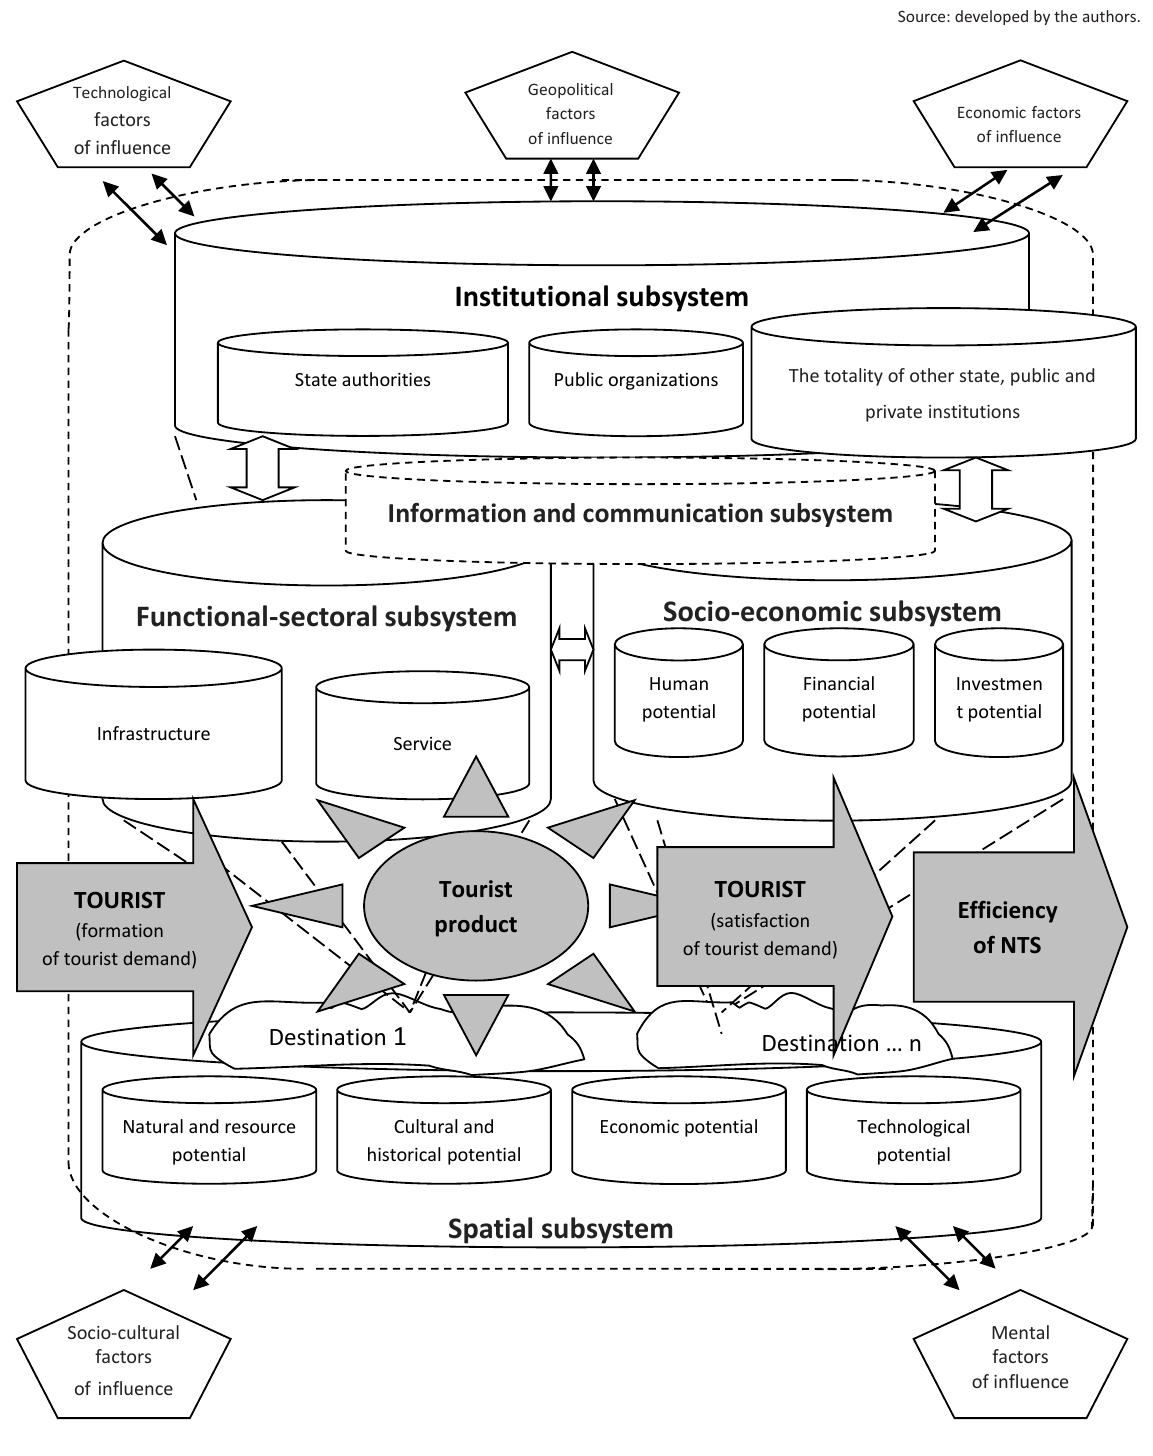
Figure 3. The structure of the national tourism